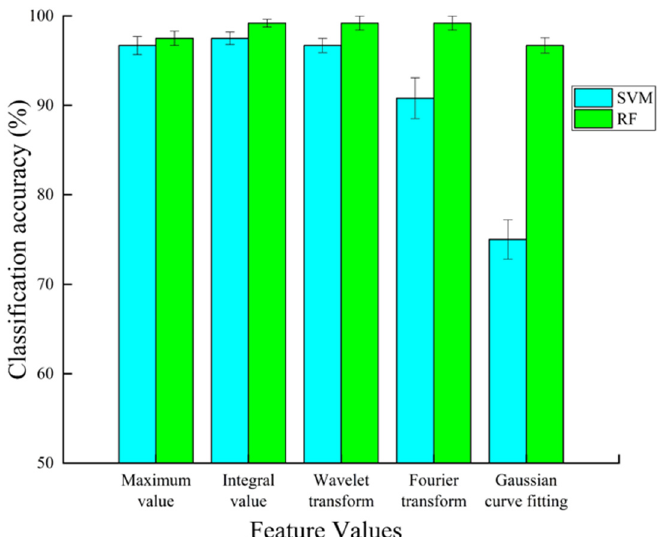
Figure 9. Recognition results of support vector machine (SVM) and random forest (RF) based on